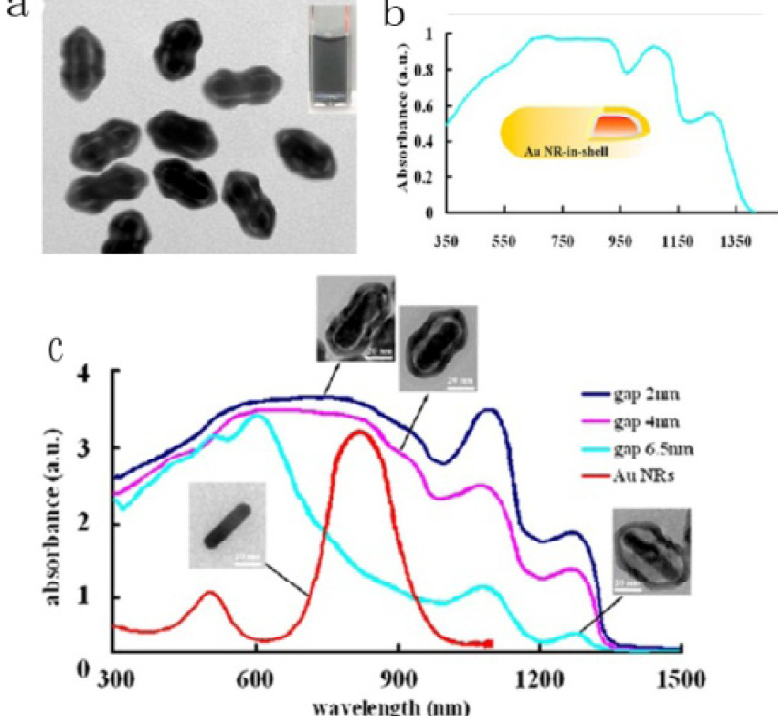
Fig. 1. (a) The TEM image of Au rod-in-shell. (b, c) The UV-vis-NIR spectra of Au rod-in-shells with diffenrent gaps and Au nanorods, measured at the same dosage amount of 50 ppm (in Au concentration), and their corresponding TEM images. Reprinted with permission from M. F. Tsai, S. H. Gilbert Chang, F. Y. Cheng // ACS nano 7 (2013) 5300. Copyright 2013 American Chemical